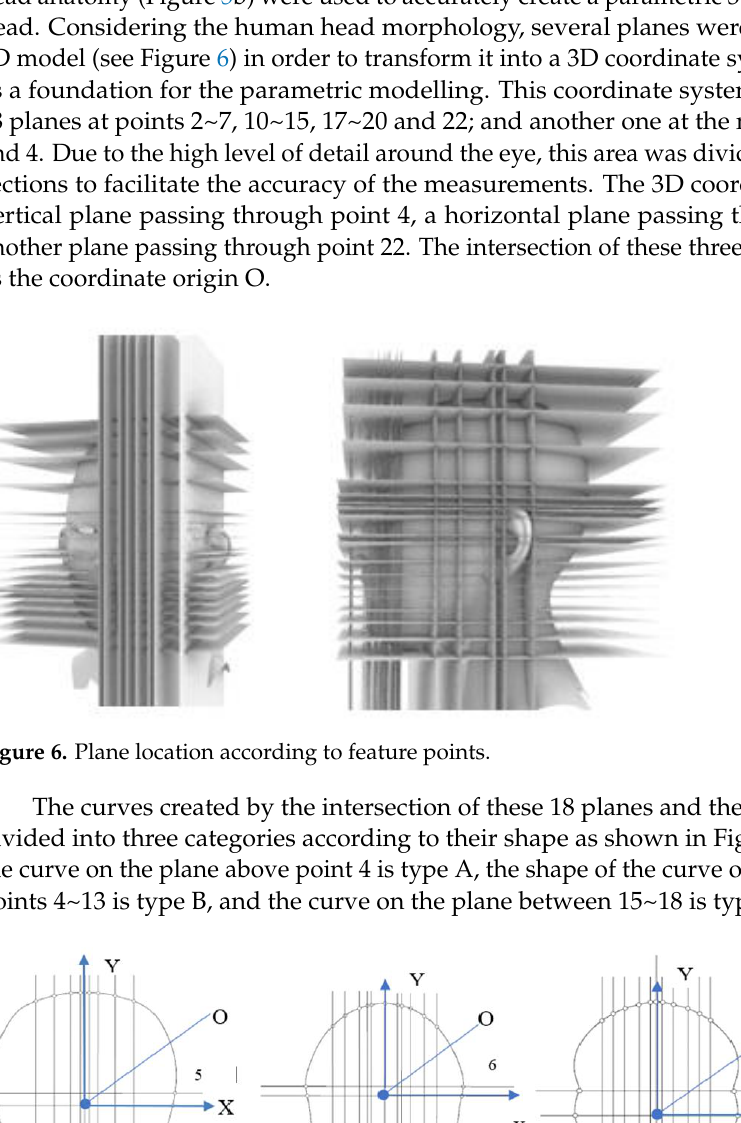
Figure 7. Type of curve.